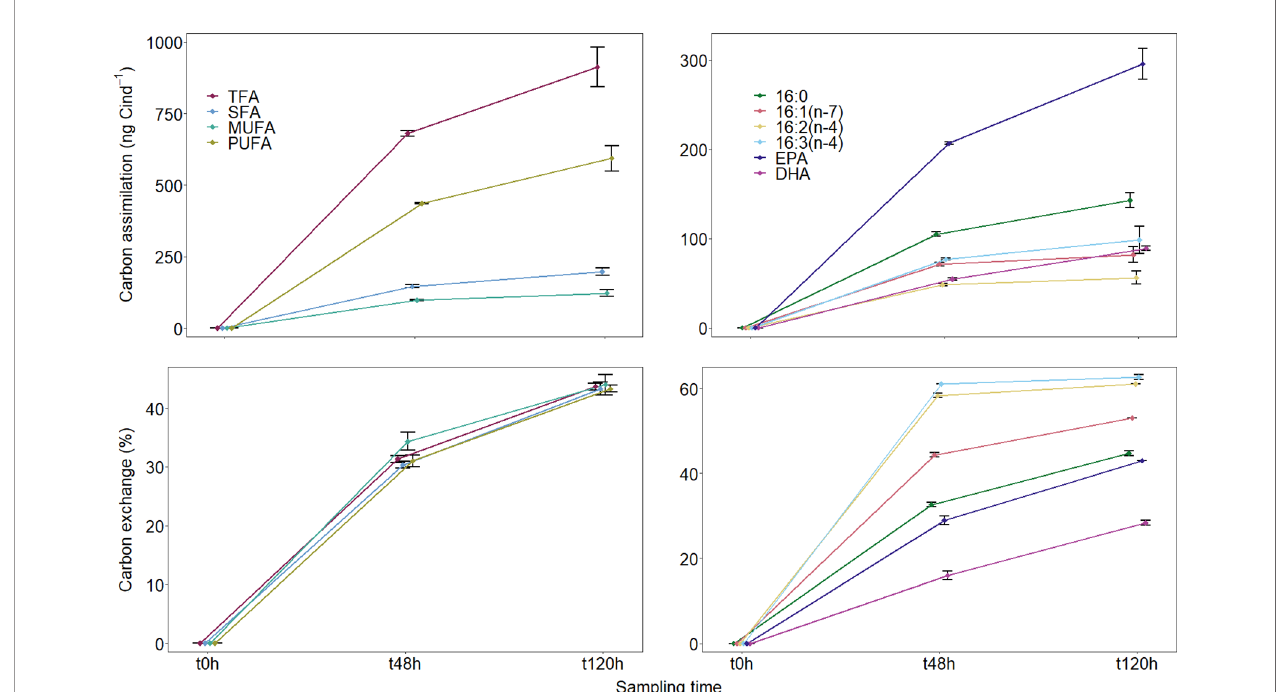
FIGURE 3 | Total (TFA), saturation-speci fi c groups (left column), and FA-speci fi c (right column) values for C assimilation (ng C ind -1 , upper row) and exchange (%, lower row) recorded for Temora longicornis during the feeding experiment (at t 48h and t 120h ). Values are mean ± standard deviation of triplicate